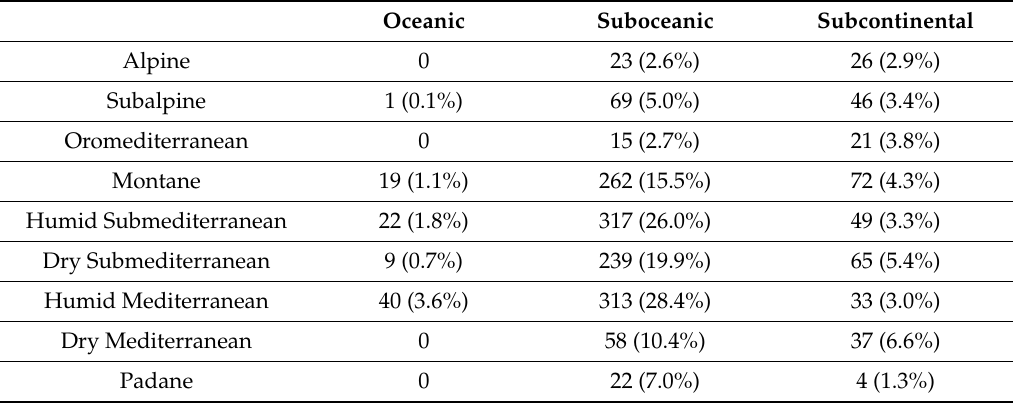
Table 3. Incidence (absolute numbers and percentages) of taxa with oceanic, suboceanic, and subcontinental phytoclimatic range in the lichen flora of the 9 ecoregions. Oceanic